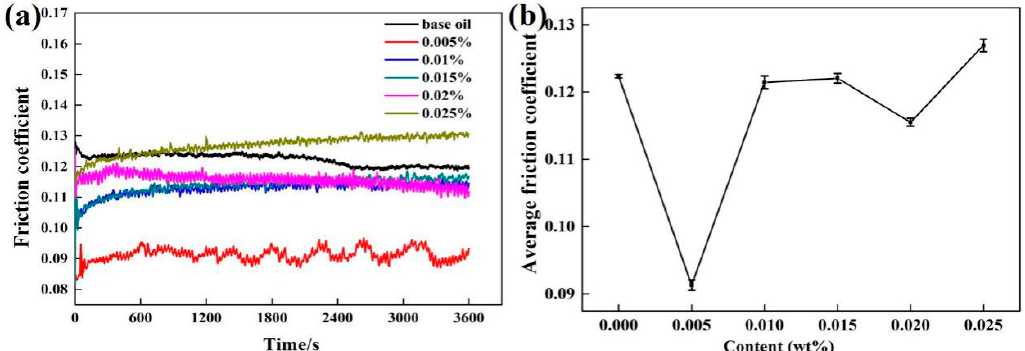
Figure 5. ( a ) The friction coefficient curves of ML-MSH/CGB oil with different addition amounts depending on friction time; and ( b ) average friction coefficient of ML-MSH/CGB oil as a function of added content.